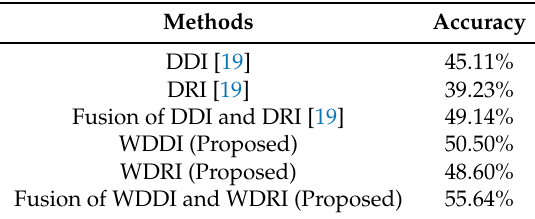
Table 2. Comparison of recognition accuracy using Weighted Dynamic Images and Dynamic Images on the validation set of ChaLearn LAP IsoGD Dataset.